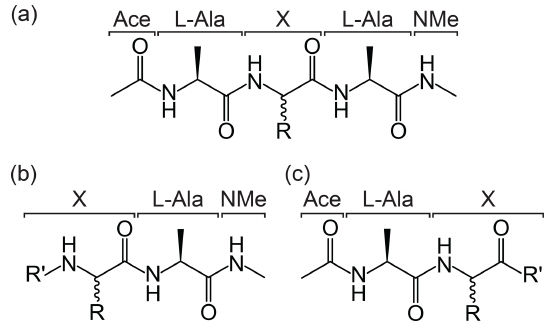
Figure 2. Template formats for submission of ncAAs to the ATB. The required templates for (a) non-terminal residue, (b) N-terminal residue and (c) C-terminal residue in a peptide chain are shown. In each case, R represents the side chain of the ncAA labelled “X”, and in the case of (b) and (c) R (cid:48) represents possible modifications of the